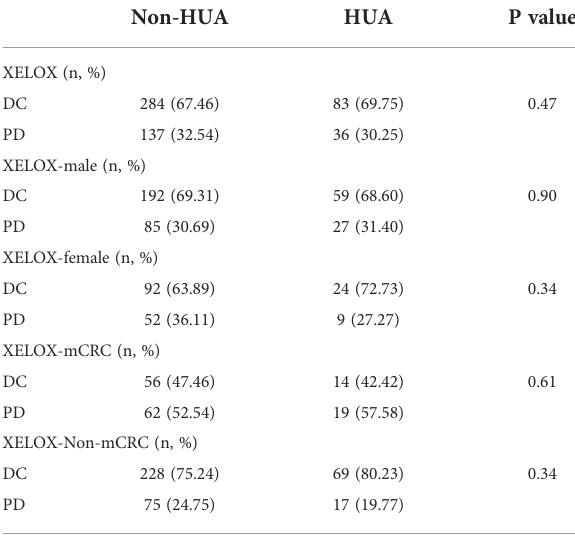
TABLE 4 Relationship between SUA levels and disease control rate in patients using XELOX following colorectal cancer surgery. Non-HUA HUA P